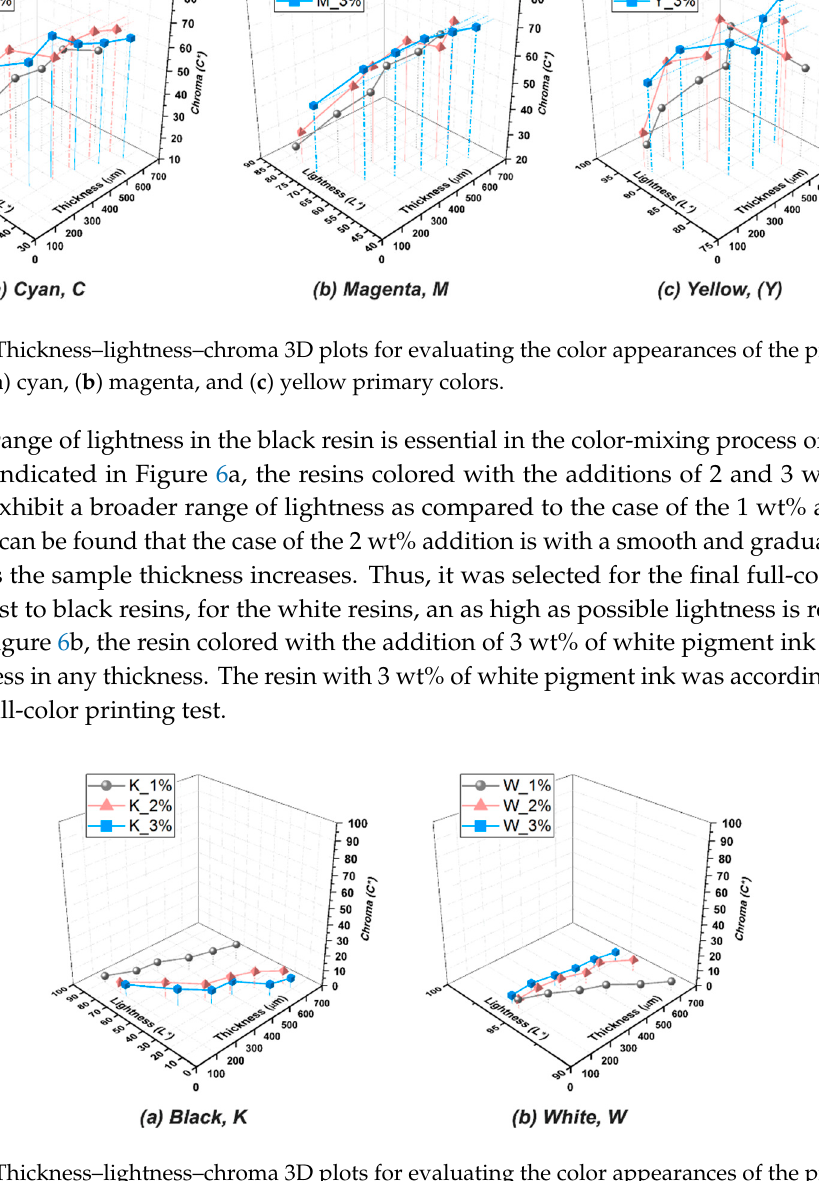
Figure 6. Thickness–lightness–chroma 3D plots for evaluating the color appearances of the prepared resins in ( a ) black and ( b ) white primary colors.